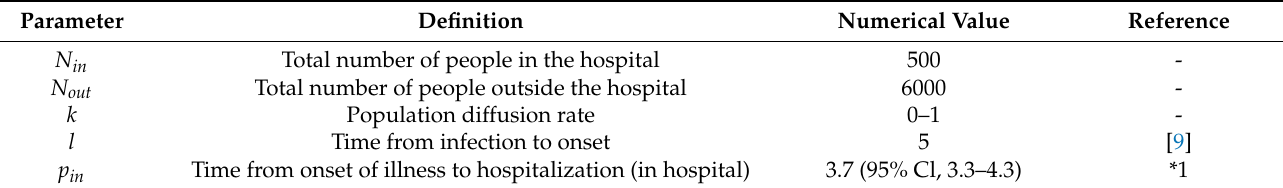
Table 1. Parameters for